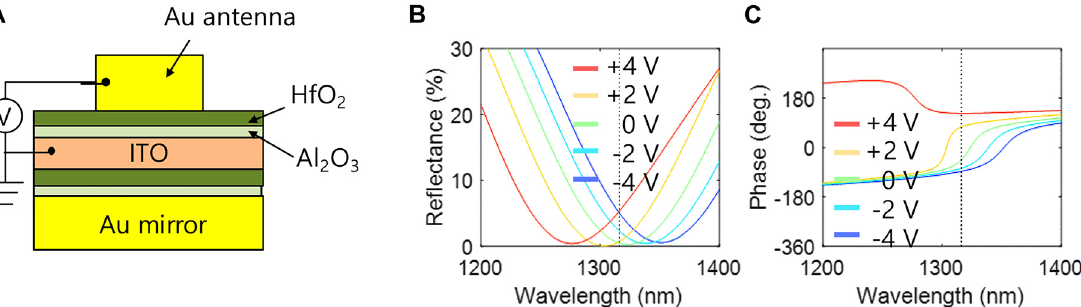
Figure 2: Design of the unit cell of the tunable metasurface. (A) Cross-sectional schematic diagram of the metasurface image. The thicknesses of the Au antenna, the HfO 2 layer, the Al 2 O 3 layer, and the ITOlayerare50nm,7nm,1nm,and5nm,respectively.Theincidentbeamisassumedtonormallyilluminatethestructurefromthetopwiththe electric fi eldcomponentperpendiculartotheantenna.(B)Simulatedre fl ectivityspectrumfortheAuantennawiththeperiodof400nmandthe width of 240 nm for the applied voltage from − 4 V to + 4 V with the increment step size of 2 V. (C) The corresponding phase